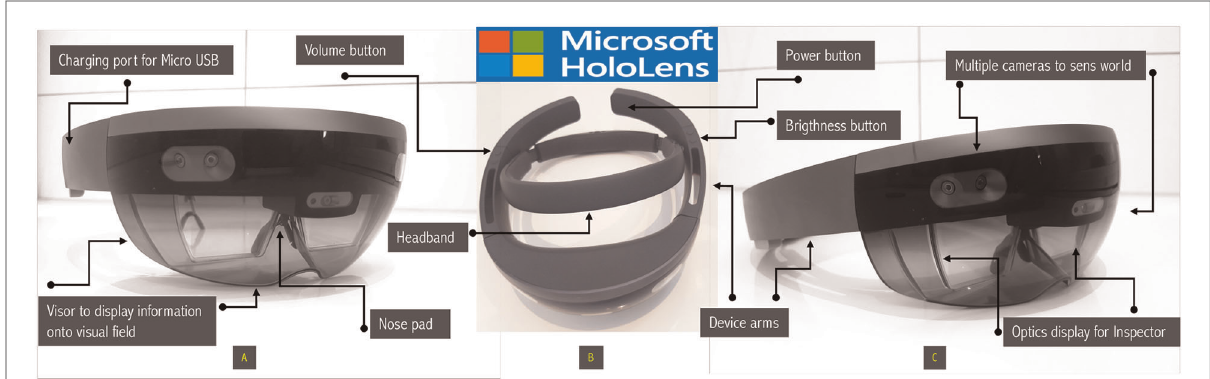
FIGURE 1 Hololens I by Microsoft® is a see-through smartglass with holographic lenses which creates 3-D models into the surrounding environment due to multiple spatial-mapping cameras and depth cameras, as well its inertial measurement unit. Navigation: eye tracking, fi nger tracking, voice commands. Processor: Holographic Processing Unit HPU 1.0 Intel 32-bit with Operating System Windows 10+ Windows Store; Memory: 2 GB RAM, 64 GB Flash Storage; Weight 759 g; Camera 2.4 MP photo; 1.1 MP HD video, video speed 30 FPS; Batery life 2 – 3 h under active use and 2